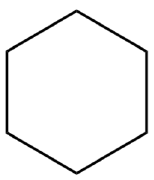
Figure 10. Graphene structure with 𝑙 = 1, 𝑘 = 1 .